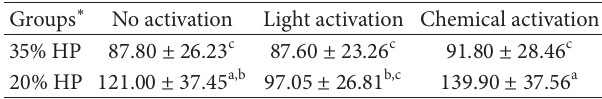
Table 1: Mean (standard of deviation) time (min) for hydrogen peroxide to reach the pulp chamber.